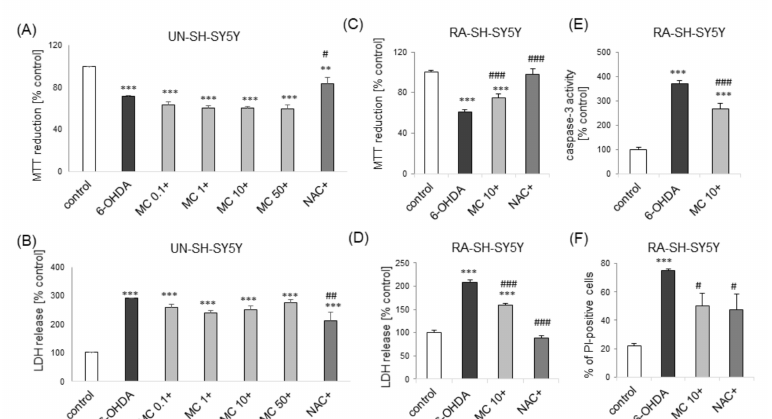
Figure 8. The e ff ect of MC on 6-OHDA-induced cell damage in UN- and RA-SH-SY5Y cells. ( A , B ) Cell viability ( A ) and toxicity ( B ) in UN-SH-SY5Y cells pre-treated for 30 min. with MC (0.1–50 µ M) or co-treated with N-acetylcysteine (NAC, 1 mM) followed by 24 h of treatment with 6-OHDA (100 µ M) as measured by MTT reduction ( A ) and LDH release ( B ) assays. Data were normalized to vehicle-treated cells and are presented as the mean ± SEM. ( C , D ) Cell viability ( C ) and toxicity ( D ) in RA-SH-SY5Y cells pre-treated for 30 min. with MC (10 µ M) or co-treated with N-acetylcysteine (NAC, 1 mM) followed by 24 h of treatment with 6-OHDA (200 µ M) as measured by MTT reduction ( C ) and LDH release ( D ) assays. Data were normalized to vehicle-treated cells and are presented as the mean ± SEM. ( E ) The e ff ect of 30-min pre-treatment with MC (10 µ M) followed by 24 h of exposure to 6-OHDA (200 µ M) in RA-SH-SY5Y cells on caspase-3 activity. Data were normalized to vehicle-treated cells and are presented as the mean ± SEM. ( F ) The e ff ect of 30-min pre-treatment with MC (10 µ M) or co-treated with N-acetylcysteine (NAC, 1 mM) followed by 24 h of exposure to 6-OHDA (200 µ M) in RA-SH-SY5Y cells on the number of necrotic nuclei measured by propidium ioide (PI) staining. Data are presented as the mean ± SEM percentage of necrotic nuclei. *** p < 0.001 and ** p < 0.01 vs. vehicle-treated cells; ### p < 0.001, ## p < 0.01 and # p < 0.05 vs. 6-OHDA-treated